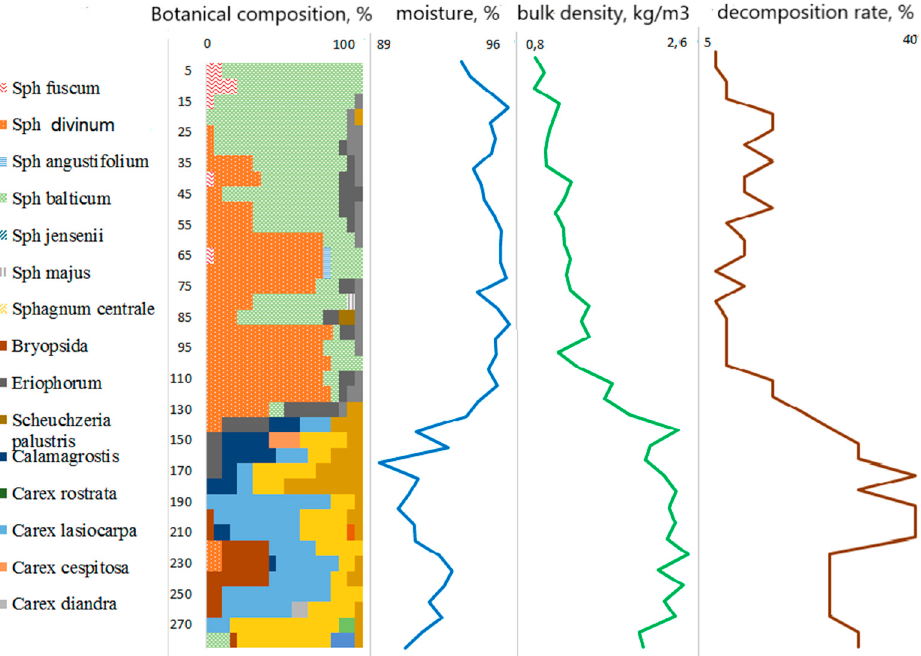
Figure 5. Peat moisture, bulk density, botanical composition and degree of decomposition in the study area of GVM.